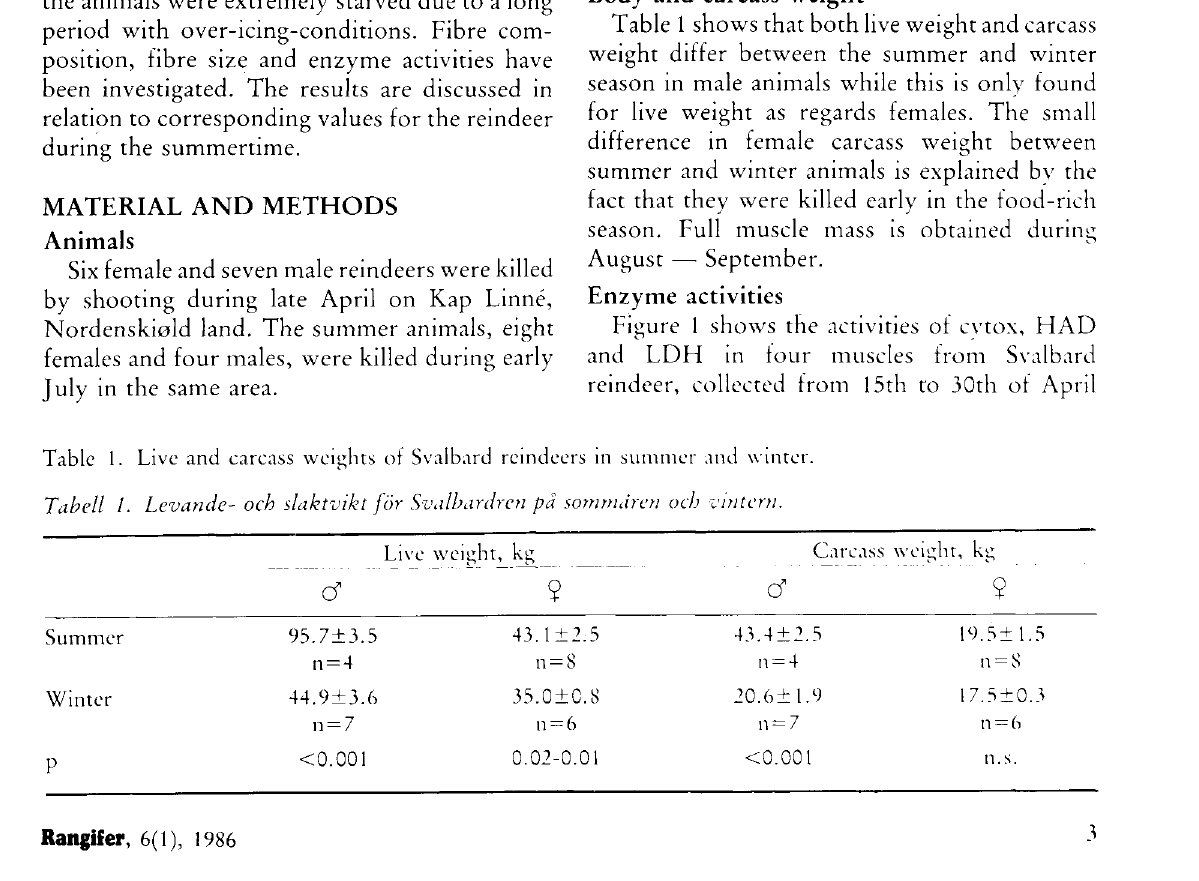
Table 1. Live and carcass weights of Svalbard reindeers in summer and